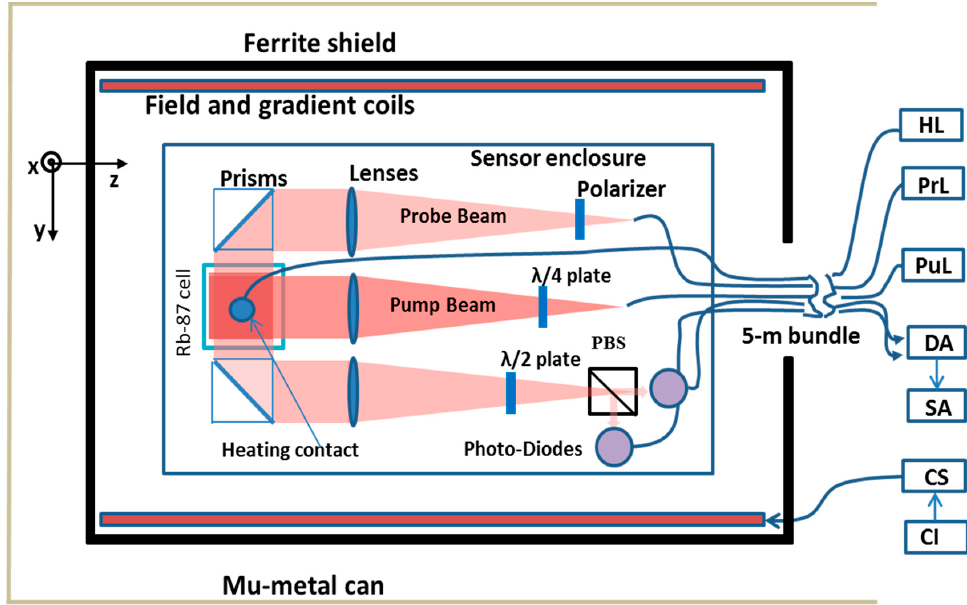
Figure 1. Diagram of fiber-coupled AM with laser heating: HL—Heating Laser, PrL—Probe Laser, PuL—Pump Laser, DA—Differential Amplifier, SA—Spectrum Analyzer, CS—Current Source, CI—computer interface.